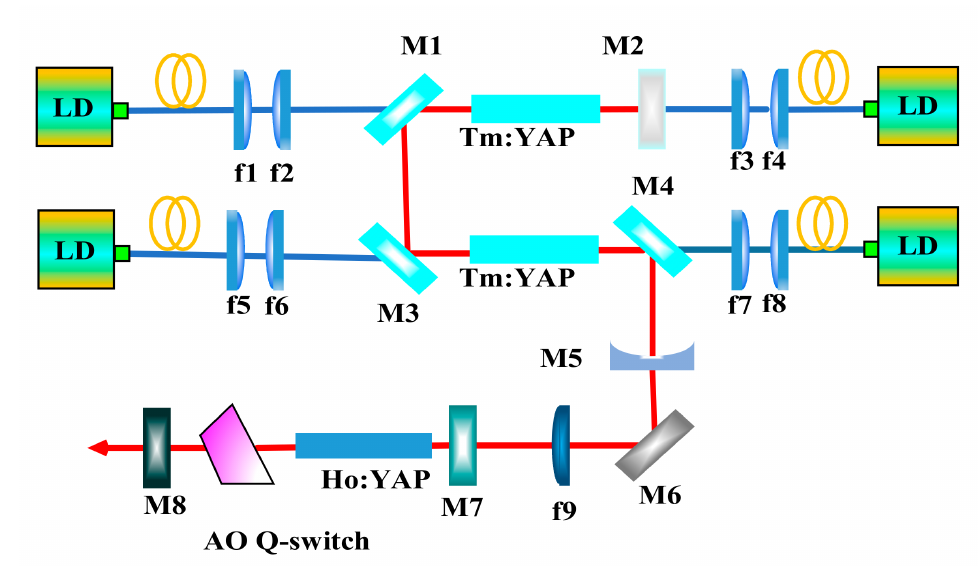
Figure 1. Acousto-optic Q-switched Ho:YAP laser pumped by 1989 nm laser. The output power of Tm:YAP laser was improved by using a laser diode (LD) double- ended pump structure. The cavity was formed by flat mirrors M1, M2, M3, M4, and a concave mirror M5. M1, M3 and M4 were 45 ◦ mirrors coated with high transmissivity at 795 nm and high reflectivity at 1989 nm. M2 was a 0 ◦ mirror coated with high transmissivity at 795 nm and high reflection at 1989 nm. Curvature radius of the output coupler M5 was 300 mm and coated with transmissivity of 10% at 1989